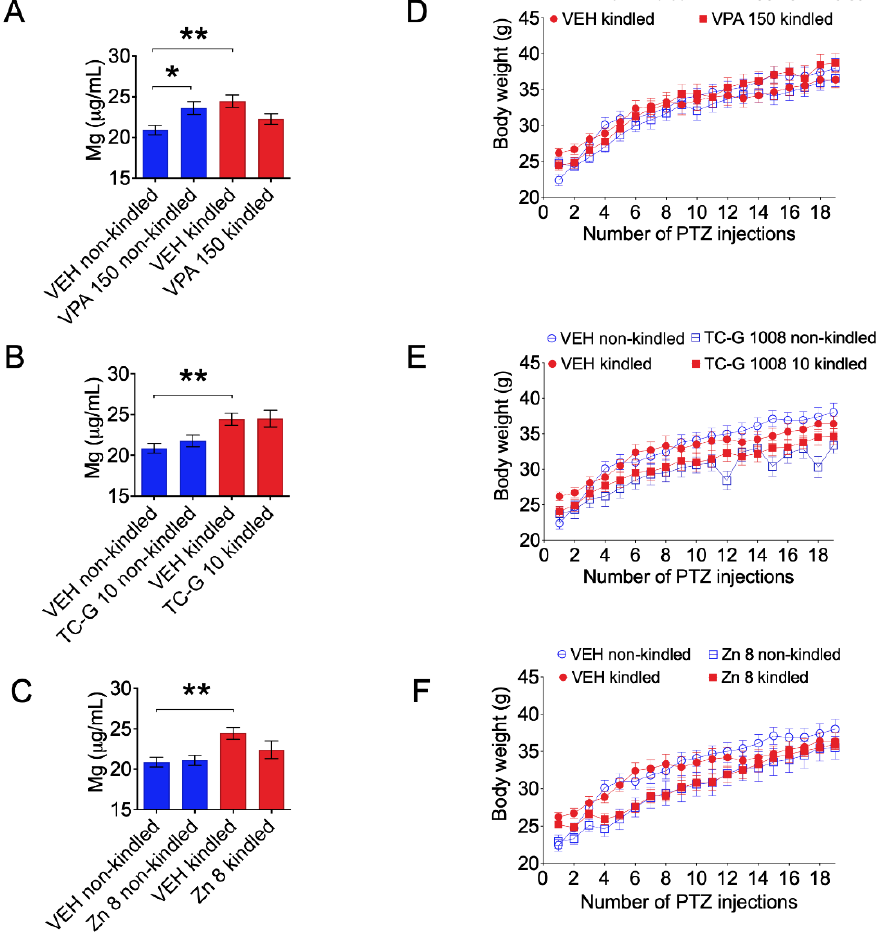
Figure 2. ( A – C ) The effects of chronic treatment with VPA (150 mg/kg) ( A ), TC-G 1008 (10 mg/kg) ( B ), or ZnCl 2 (8 mg Zn/kg) ( C ) in the pentylenetetrazole (PTZ)-induced kindling model of epilepsy on total serum magnesium concentration. Drugs or VEH (1% Tween 80 in physiological saline) were injected i.p. once daily on every alternate day during weekdays in Swiss albino mice. In kindled mice, PTZ (40 mg/kg) was injected i.p. 30 min later. Non-kindled mice received physiological saline instead of PTZ. The model consisted of 19 injections of PTZ. Total serum magnesium concentration was measured by ICP-OES at 24 h after the completion of the model. Data are expressed as means ± SEM. Data were analyzed by two-way ANOVA and Tukey’s multiple comparison test. Statistical details: ( A ) VPA [F(1,35) = 0.1492, p = 0.7016], PTZ kindling [F(1,35) = 2.522, p = 0.1213], VPA × PTZ kindling [F(1,35) = 12.29, p = 0.0013]; n = 10 VEH non-kindled, VEH kindled, VPA 150 non-kindled, n = 9 VPA 150 kindled ( B ) TC-G 1008 10 [F(1,35) = 0.4007, p = 0.5308], PTZ kindling [F(1,35) = 15.05, p = 0.0004], TC-G 1008 × PTZ kindling [F(1,35) = 0.3397, p = 0.5637]; n = 10 VEH non-kindled, VEH kindled, TC-G 1008 10 non-kindled, n = 9 TC-G 1008 10 kindled ( C ) Zn [F(1,35) = 1.376, p = 0.8032], PTZ kindling [F(1,35) = 9.813, p = 0.035], Zn × PTZ kindling [F(1,35) = 2.122, p = 0.1541]; n = 10 VEH non-kindled, VEH kindled, Zn 8 non-kindled, n = 9 Zn 8 kindled (by two-way ANOVA). * p < 0.05, ** p < 0.01 (by Tukey’s multiple comparison test). ( D – F ) The effects of chronic treatment with VPA